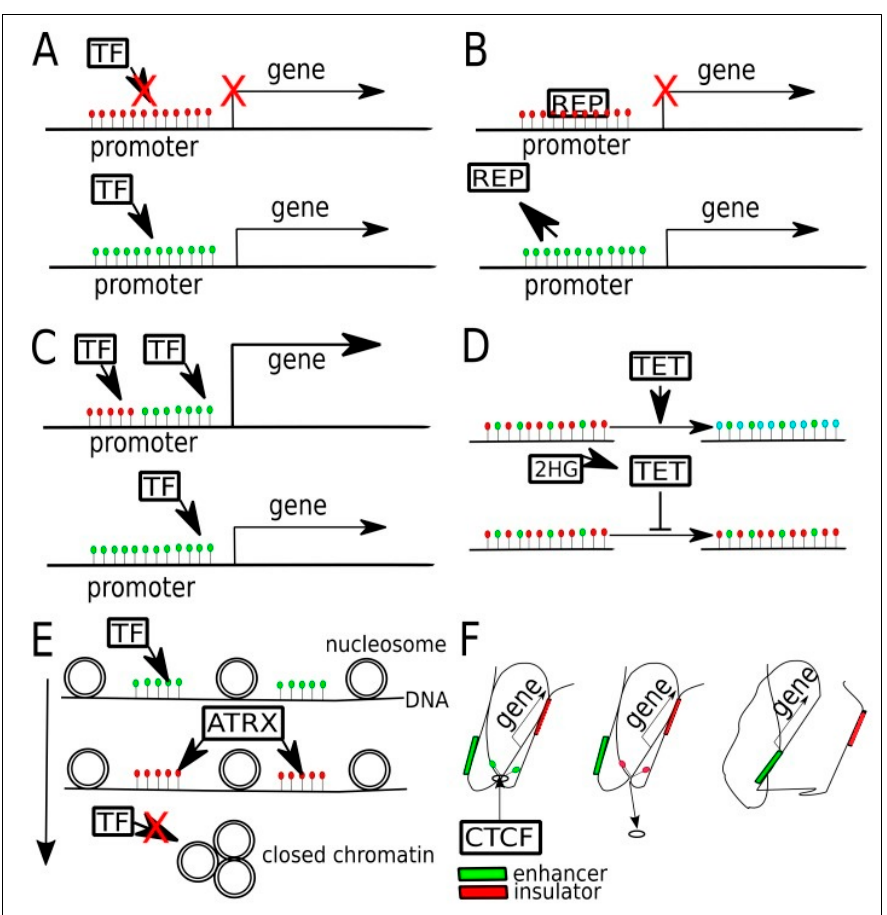
Figure 5. Potential targets in the various pathways where DNA methylation plays a role in regulating gene expression in gliomas. (Green dots are unmethylated Cytosine, red dots are 5-methylCy- tosine; blue dots are 5-hydroxymethylcytosine). ( A ) Promoter hypermethylation may prevent the binding of transcriptional factors (TF), i.e., activator, leading to gene silencing. ( B ) In some other cases, a hypermethylated promoter may bind to the transcriptional repressor (REP) preferentially. When active demethylation occurs, REP is unable to bind and gene expression occurs. ( C ) In another gene, there may occur binding by two transcriptional factors (TFs), one to a methylated sequence and another to an unmethylated sequence. ( D ) In normal cells, TET enzymes convert 5mc to 5hmc and later into 5cac for maintenance purposes. When 2-Hydroxyglutarate (2-HG), a byproduct of mutant IDH enzymes, inhibits TET, a state of global hypermethylation occurs. ( E ) Relationship be- tween DNA methylation and chromatin compaction. The latter is regulated by chromatin chaper- ones that are in turn affected by DNA methylation, histone methylation, and histone acetylation. ATRX binding to methylated gene sequences leads to an increased proportion of heterochromatin, thus reducing the binding of transcriptional factors (TFs) to DNA. ( F ) When CTCTF binding sites on the genome are methylated, then CTCF is unable to bind, leading to alteration in chromatin com- paction. This causes an exchange of an insulator by an enhancer near the said sequence. Figure re- produced, with color correction, under Creative Commons Attribution-Noncommercial 4.0 license from [45].